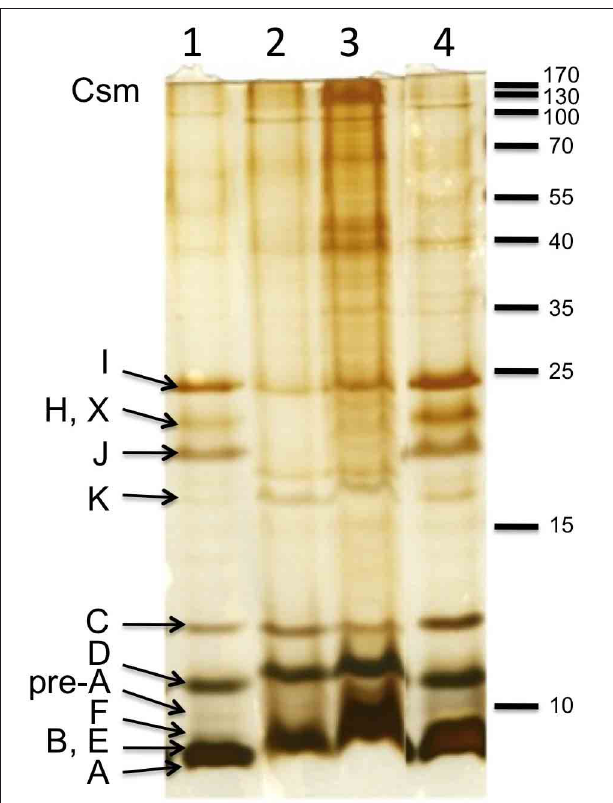
FIGURE 8 | Absorption spectra of chlorosomes from C. limnaeum WT (solid line) and bchU mutant (dotted line) at room temperature (A) and 77K